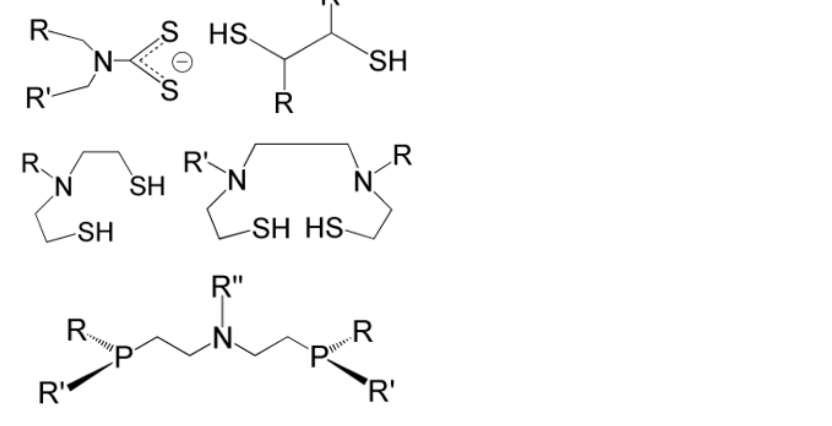
Figure 9. The general structure of some examples of bidentate and tetradentate ligands employed in the production of monoxo and nitrido 188 Re radiopharmaceuticals with sp geometry ((R, R’, R” = any pendant organic substituent) [6,8,25,49,50].